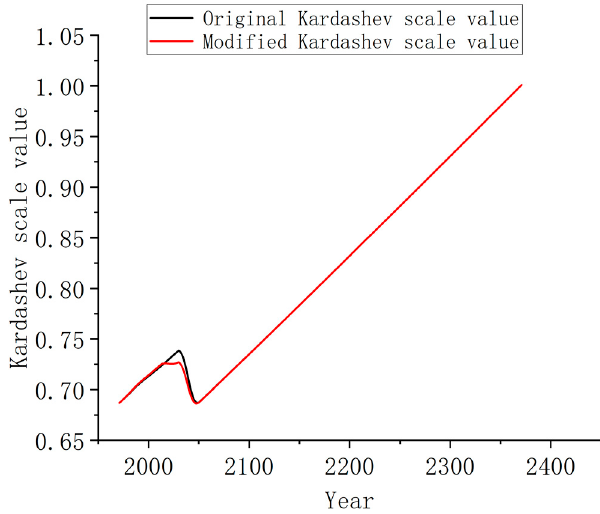
Figure 7. The K value in the constrained model.